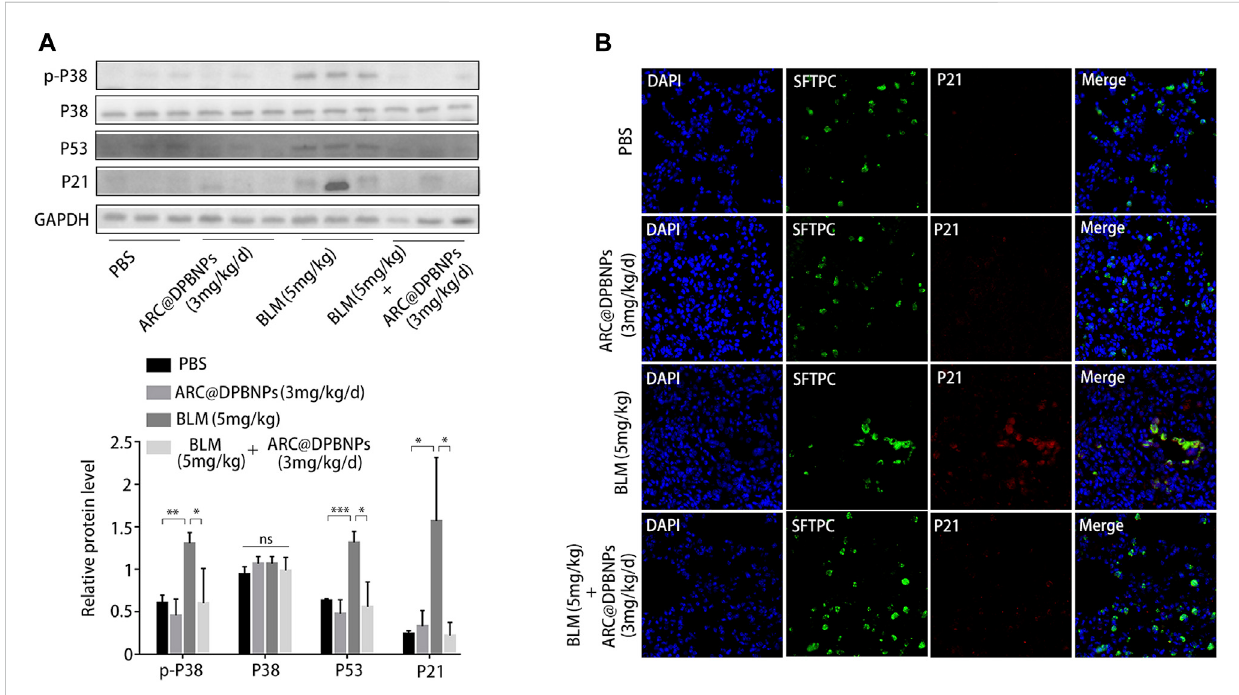
FIGURE 10 Arctiin-encapsulated DSPE-PEG bubble-like nanoparticles (ARC@DPBNPs) suppress AEC2 senescence by inhibiting the p38/p53/p21 pathway. (A) Western blot of p-p38MAPK, p53, and p21 expression in lung tissue of mouse models treated with phosphate-buffered saline, ARC@DPBNPs (3 mg/kg/ mL), bleomycin (BLM) (5 mg/kg), and BLM (5 mg/kg) + ARC@DPBNPs (3 mg/kg/mL) respectively. (B) Immuno fl uorescence staining of SFTPC (an AEC2- speci fi c marker, green) and p21 (red) was performed to con fi rm that senescent markers were expressed primarily in the AECs (original magni fi cation = ×400). * p < 0.05, ** p < 0.01, *** p < 0.001; ns: not signi fi